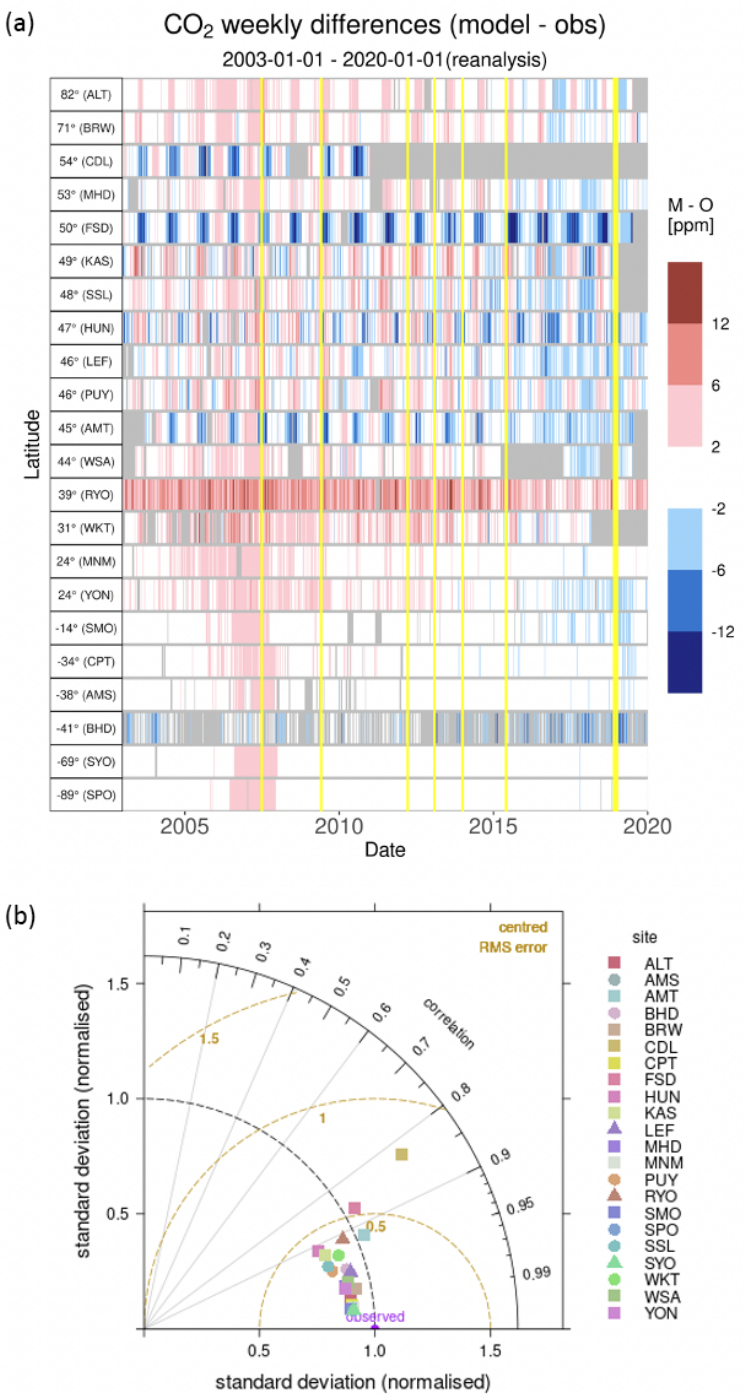
Figure 8. (a) Mosaic plot of CO 2 weekly biases (in ppm) of the CAMS GHG reanalysis compared to surface continuous observations of CO 2 mole fraction obtained from the GLOBALVIEWplus CO 2 ObsPack v6.0 (Schuldt et al., 2020) listed in Table A1. Each coloured vertical line represents a weekly mean. Vertical yellow lines depict the changes in the assimilated data documented in Figs. 1, 5 and 6. Grey shading indicates no observations are available. (b) Taylor diagrams for the site-dependent CO 2 comparison of the CAMS GHG reanalysis against the same observations used in (a) . The standard deviation is normalised by dividing the observed and modelled time series by the standard deviation of the observations. The model has higher (lower) variability compared to the observed data if the site is plotted with a distance larger (smaller) than 1 from the